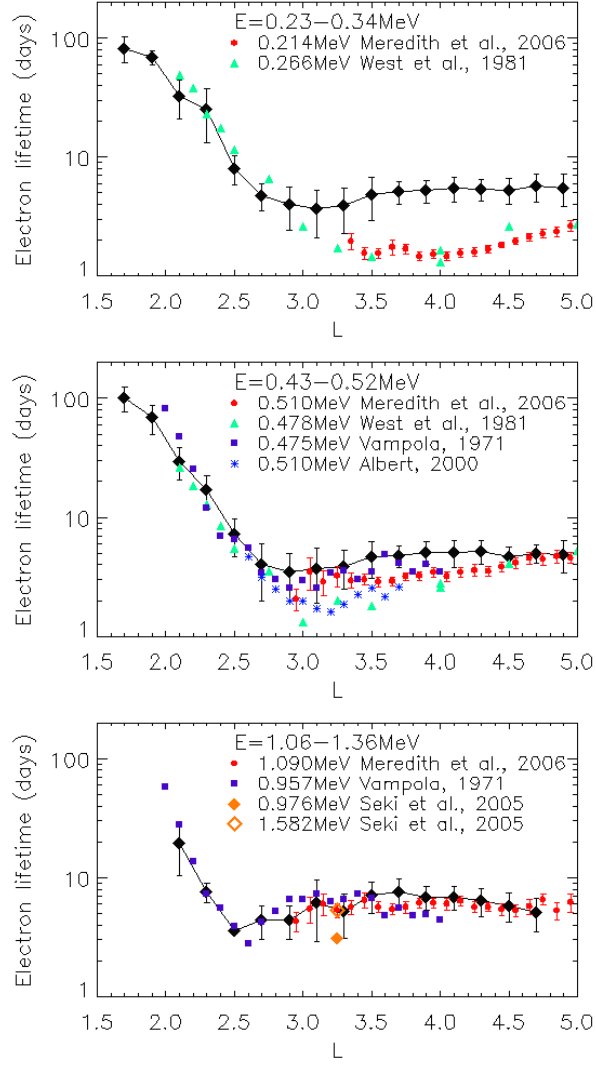
Fig. 4. Observed lifetimes (black dots) versus L for three differ- ent energy ranges. Comparison to other measured decay timescales taken from the indicated